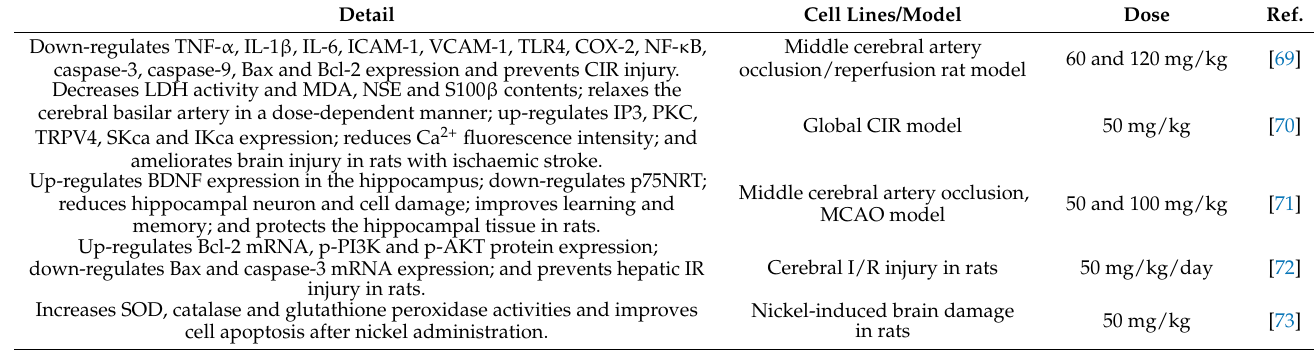
Table 5. Brain-Protective Activity of